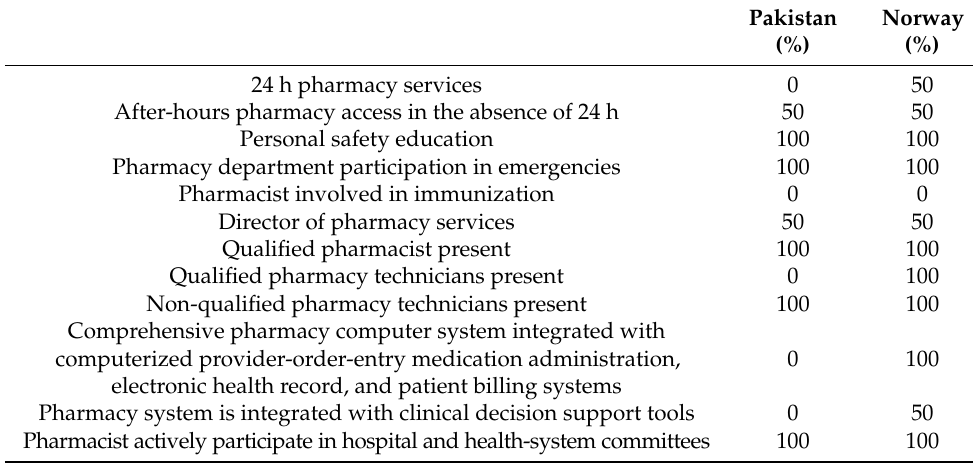
Table 2. Pharmacists’ assessments on pharmacy service